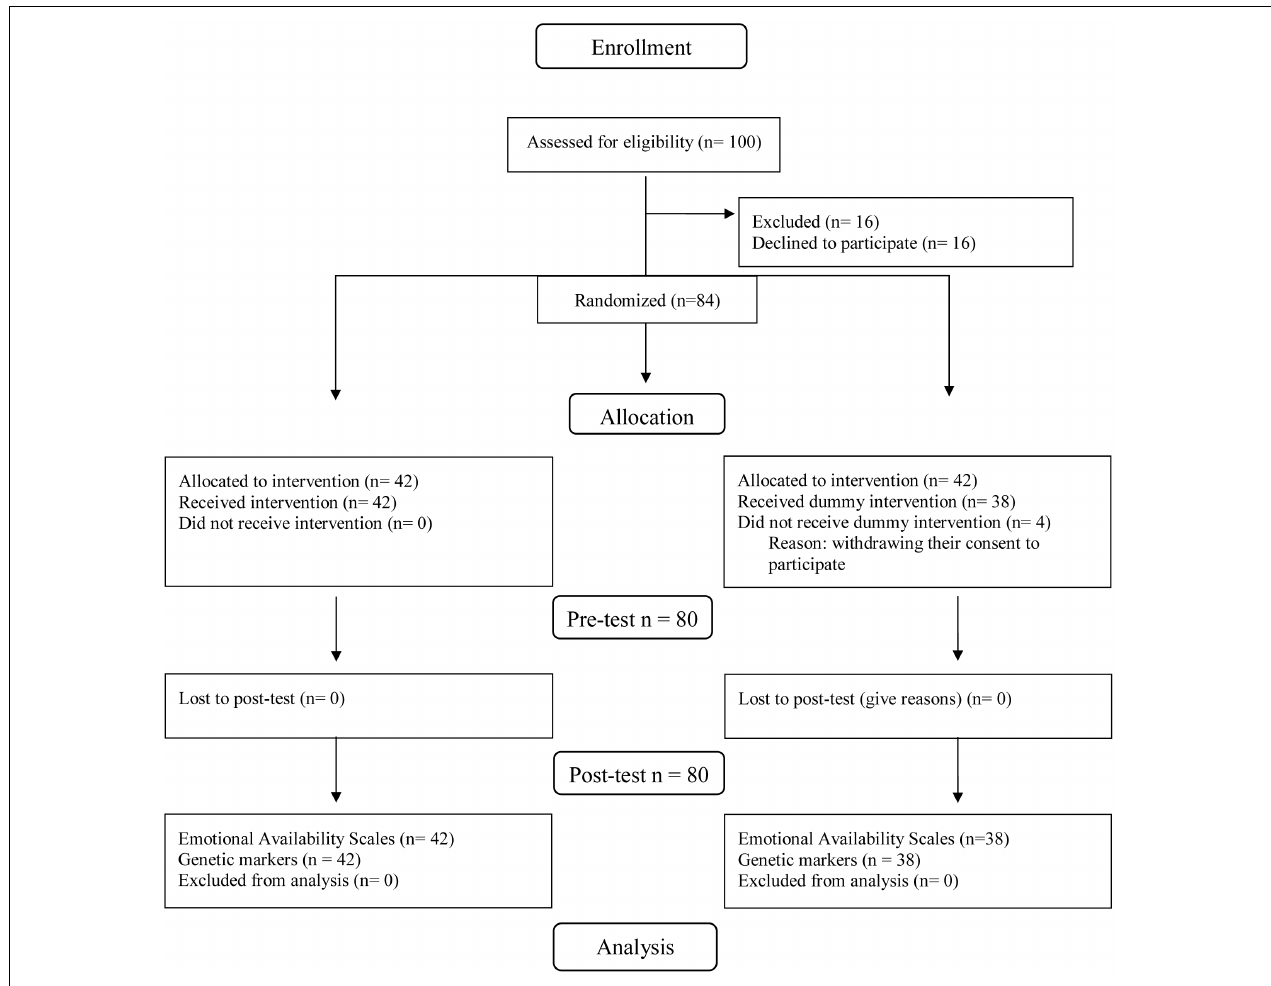
FIGURE 1 | Consort Flow Diagram of the study’s progress, detailing participant numbers during recruitment, inclusion,